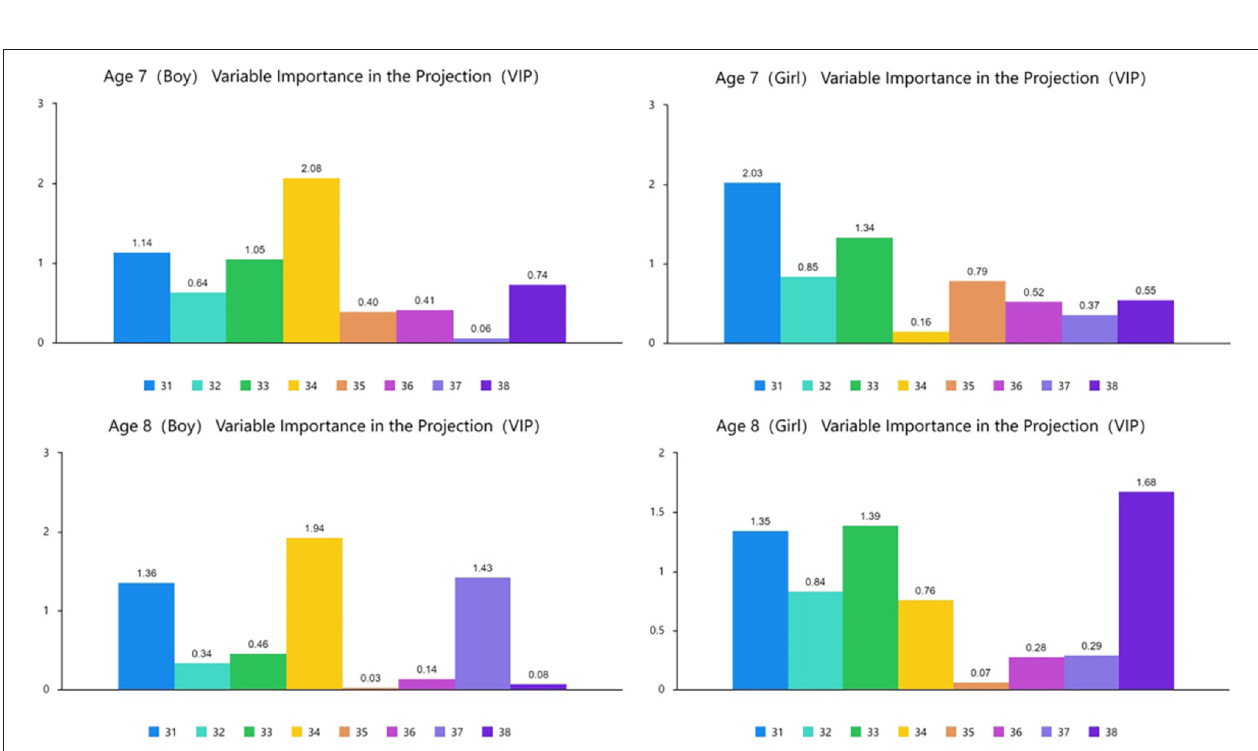
FIGURE 7 | VIP chart of the projection importance index of motor development to motor performance.